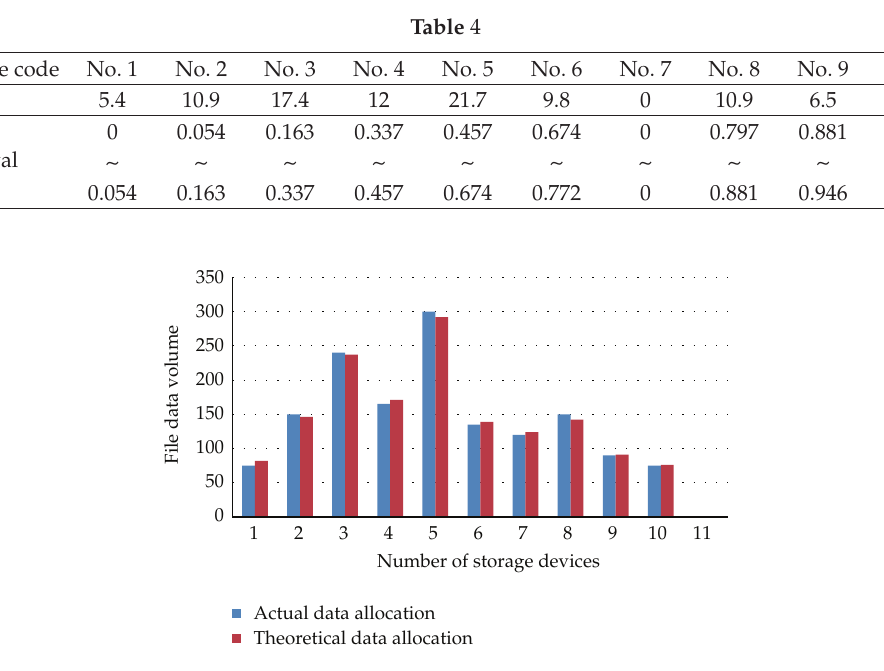
Figure 5: Comparison between actual and theoretical allocation.